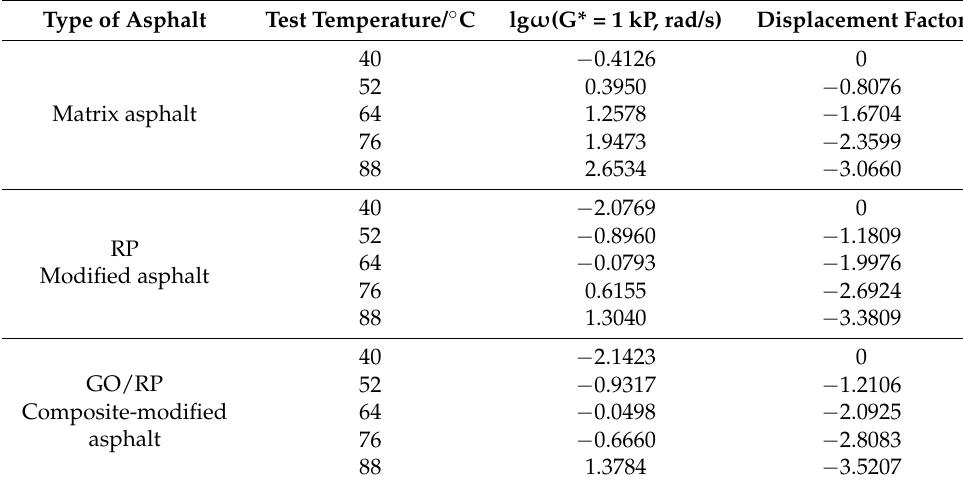
Table 5. Summary of various asphalt displacement